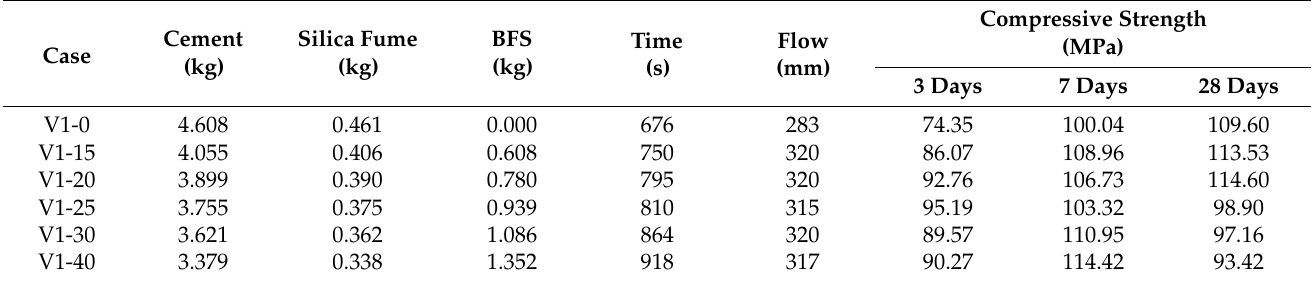
Table 6. Mixing time, flow, and compressive strength of V1 samples.